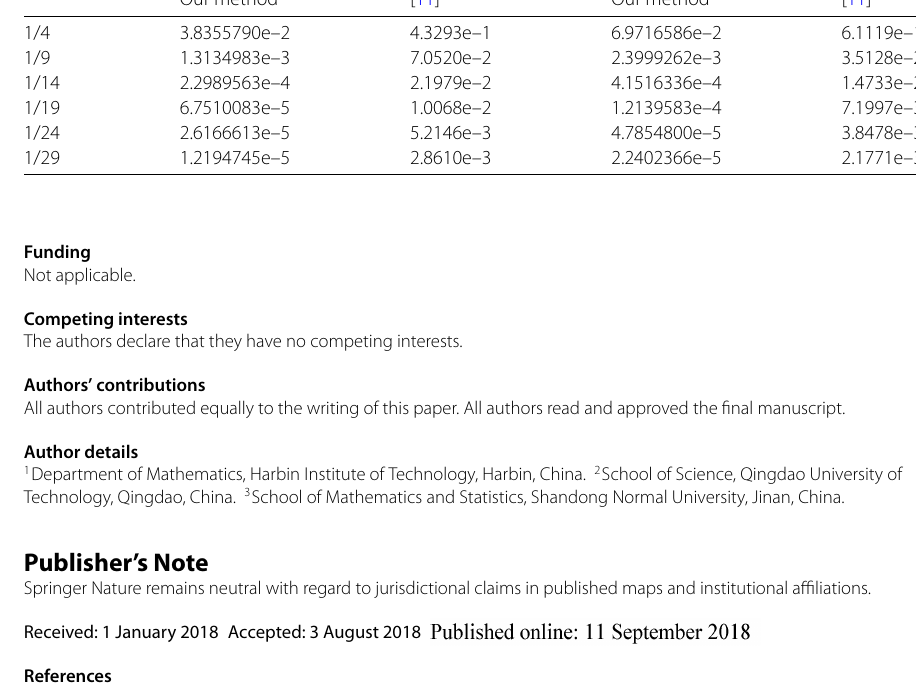
Table 4 Comparison of errors obtained for Example 1 with τ = 1